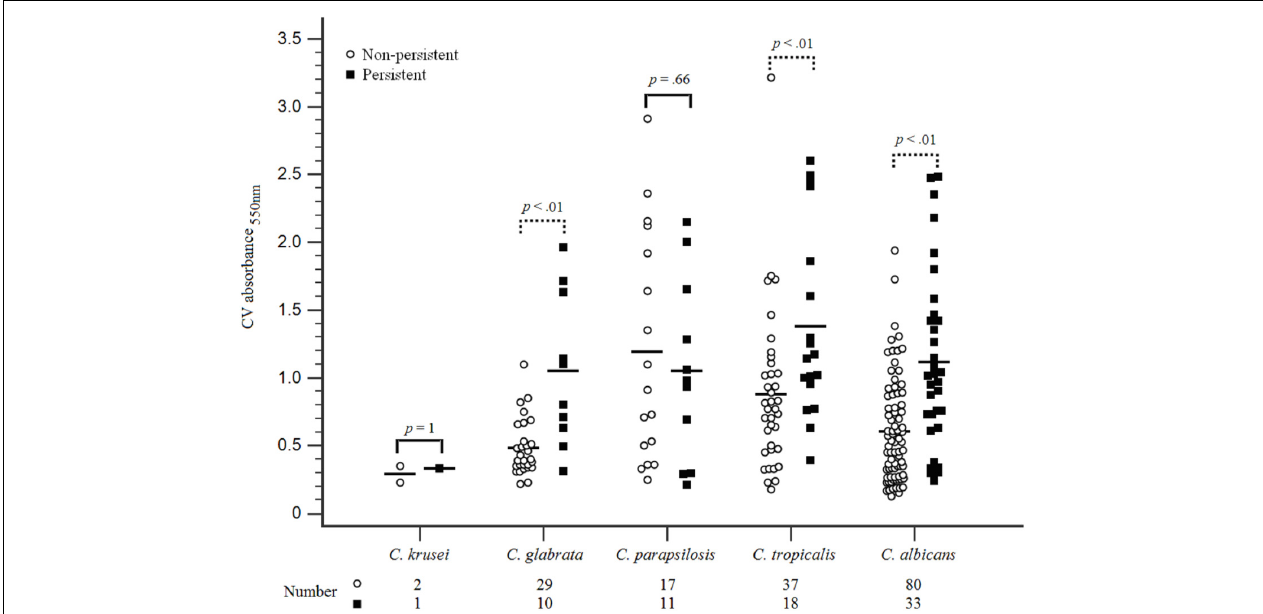
FIGURE 2 | Biofilm formation on Candida species isolated from patients with persistent and non-persistent candidemia. Candida bloodstream strains isolated from all included patients were evaluated for biofilm formation with standardized methods. The first Candida spp. isolate was conducted for biofilm formation evaluation when multiple isolates were collected from some of these patients within the study period. Candida isolates standardized (1 × 10 6 cells/mL) in RPMI-1640 were grown in flat-bottomed 96-well microtiter plates for 24 h at 37 ◦ C. The biomass quantified by staining with 0.05% w/v crystal violet solution. Biomass was quantified spectrophotometrically by reading the optical density (OD) at 550 nm in a microtiter plate reader (FluoStar Omega BMG Labtech, Aylesbury, United Kingdom). Three replicates were used for each isolate. The outlier was abandoned and the average of the 2 remaining values was represented. Higher biofilm formation in C. albicans , C. tropicalis , and C. glabrata were found among isolates in the persistent candidemia group compared with those in the non-persistent candidemia group.